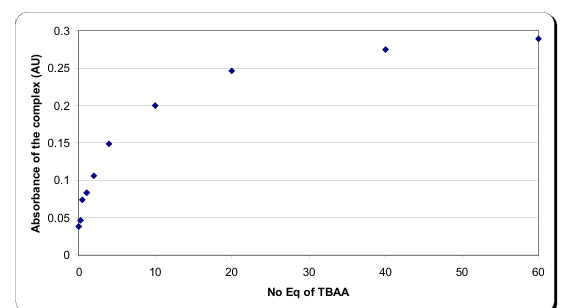
Figure 3. Titration of H7 with TBAA in acetonitrile. Table 4. Titration of H7 with TBAA in acetonitrile.